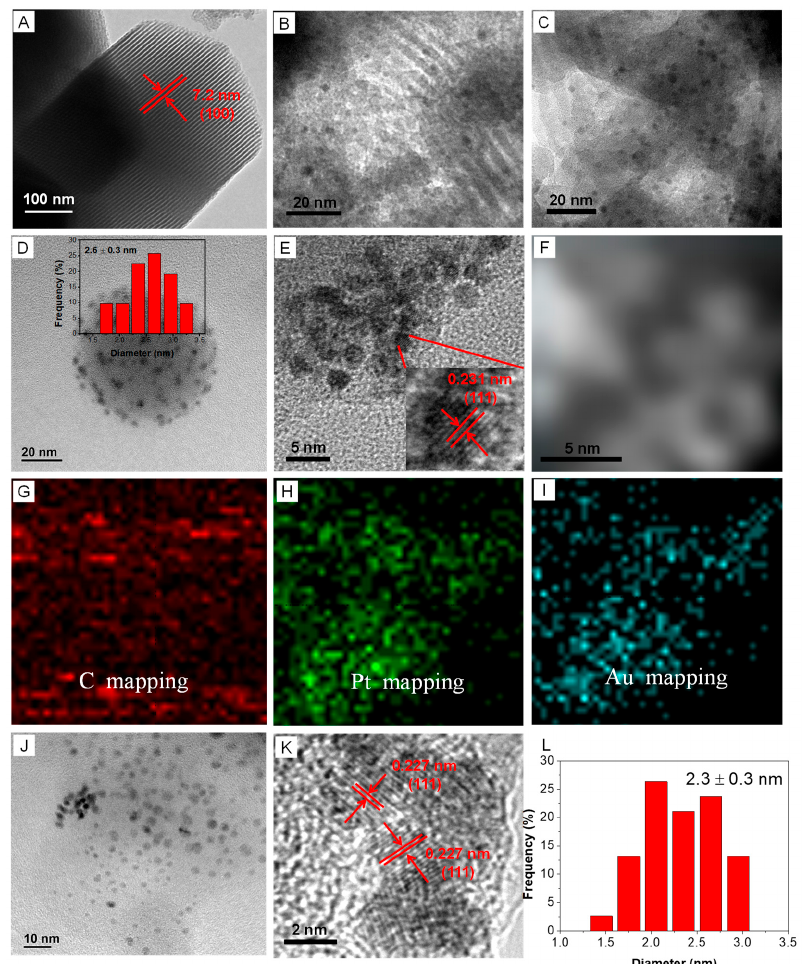
Figure 3. TEM image of PtAu/ZSBA ( A ) without calcination. TEM images of PtAu/carbon ZSBA ( B ) and Pt/carbon ZSBA ( C ) after calcination. TEM images and corresponding sub-nanosized PtAu particle distribution of PtAu/3D carbon ( D , E ). HAADF-STEM and EDX elemental mapping images of PtAu/3D carbon ( F – I ). TEM images and corresponding sub-nanosized Pt particle distribution of Pt/3D carbon ( J – L ).